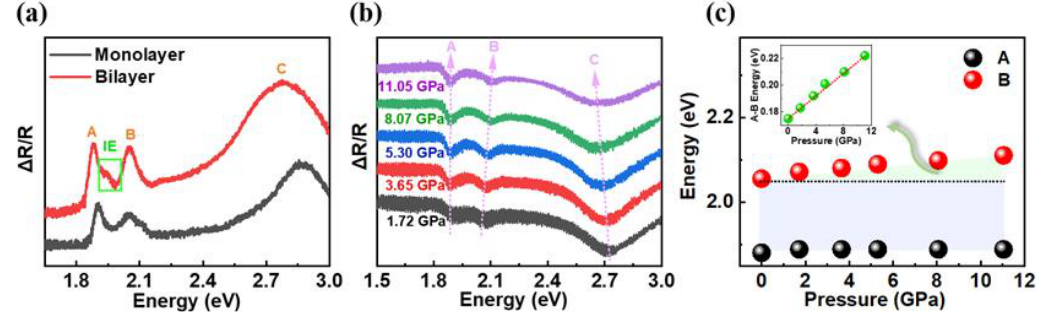
Figure 3. ( a ) The reflectivity spectra of monolayer and bilayer MoS 2 without the top diamond anvil (under ambient conditions); A, B and C are the exciton transitions. ( b ) Pressure-dependent reflectivity spectra of bilayer MoS 2 . ( c ) Dependence of A and B energy on the pressure for bilayer MoS 2 . Inset: the energy splitting between A and B exciton as a function of pressure.